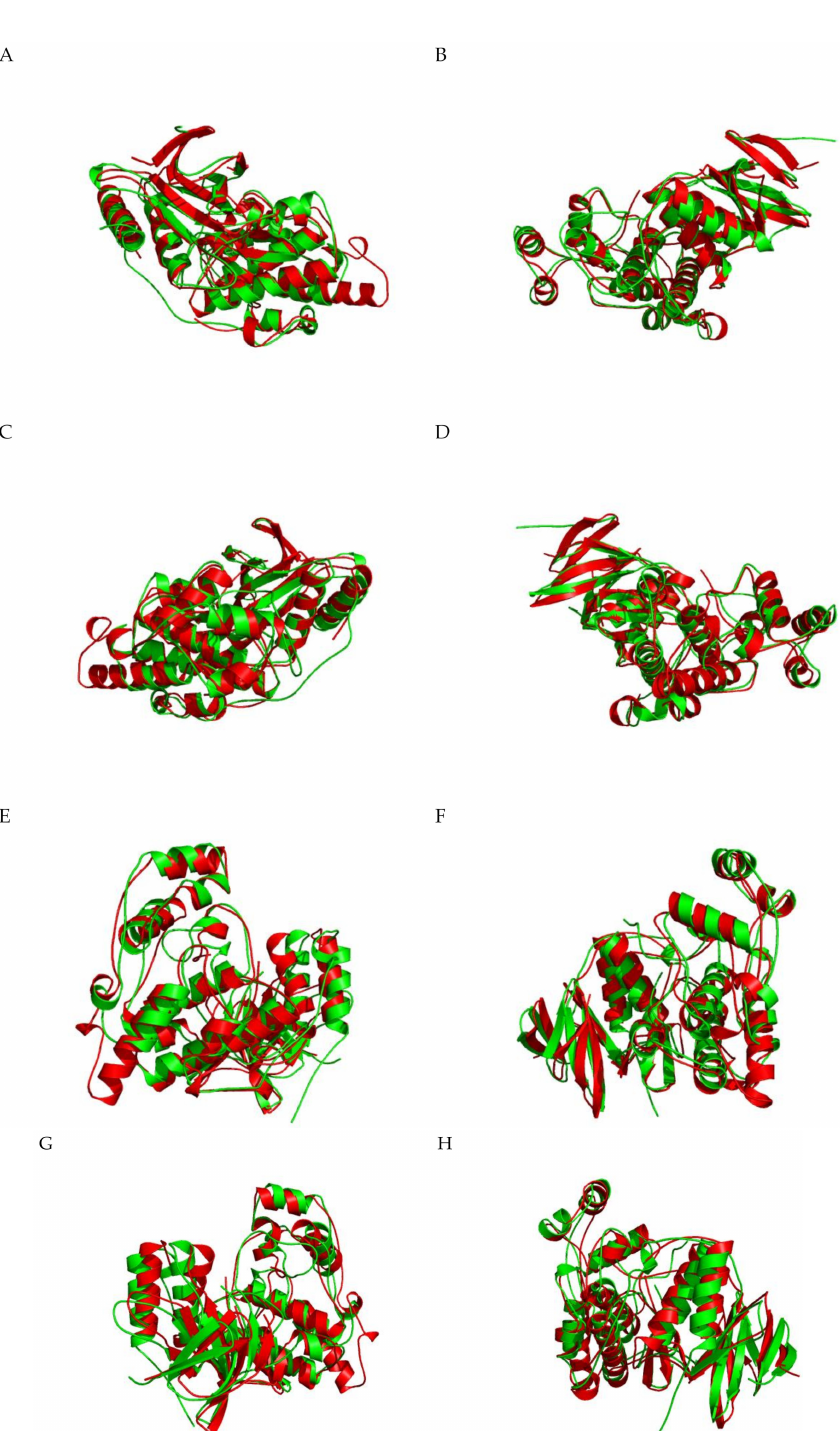
Figure 4. ( A – D ) Structural superposition of JNK3 (PDB code: 3OY1, chain A, represented in red) and ERK1 (PDB code: 2ZOQ, chain A, represented in green); ( E – H ) Structural superposition of JNK3 (PDB code: 3OY1, chain A, represented in red) and p38 α (PDB code: 1A9U, chain A, represented in green). Figure generated by